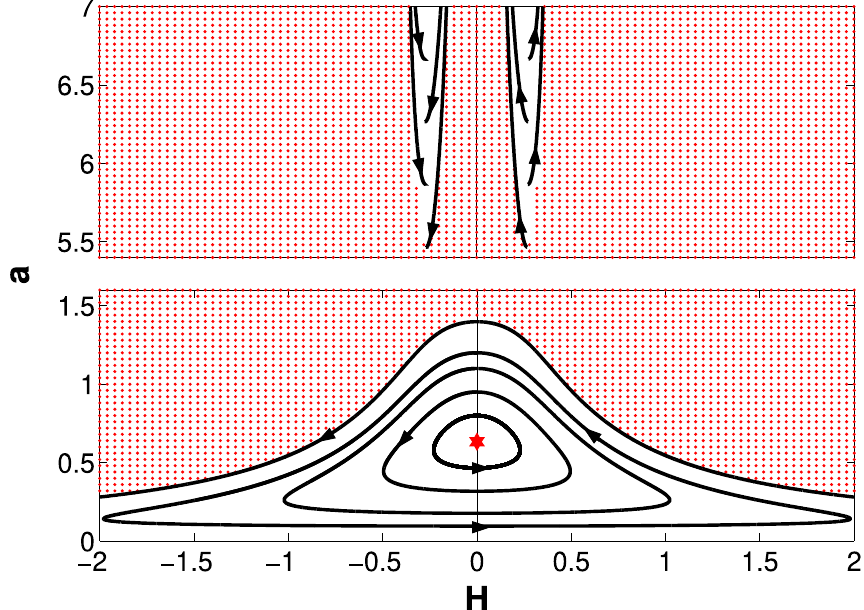
, k = 1, w = − 0 . 5 (left) and w = 0 (right). The star denotes the stationary point. The 5